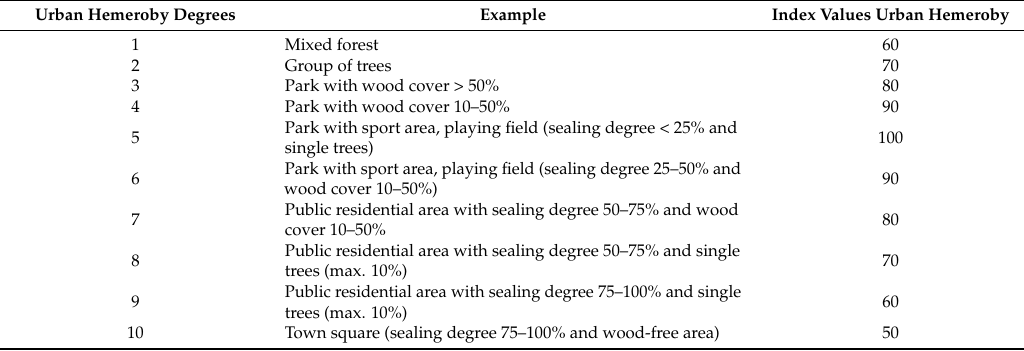
Table 8. Index values for the assessment of “social interaction and leisure activities” for the assessment in GISCAME. All private areas were valuated with “no provision of this ecosystem service”. Value 100 = highest ecosystem service capacity; 0 = lowest/no ecosystem service capacity.